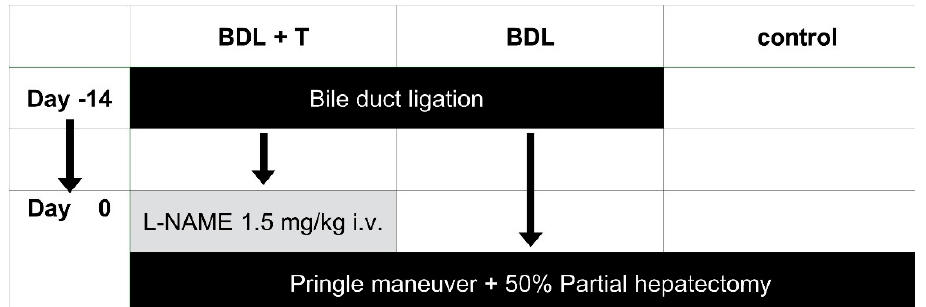
Figure 1. To investigate the effect of a nitric oxide synthase (NOS) inhibitor on ischemia–reperfusion injury (IRI) after the Pringle maneuver and partial hepatectomy of cholestatic livers induced by bile duct ligation (BDL) rats underwent BDL surgery to induce biliary cirrhosis in the BDL + T and BDL groups. Fourteen days later, 50% partial hepatectomy with PM was performed in all groups. The rats in the BDL + T group were additionally intravenously injected with N-Nitroarginine methyl ester (L-NAME) (1.5 mg/kg) 15 min before PM.